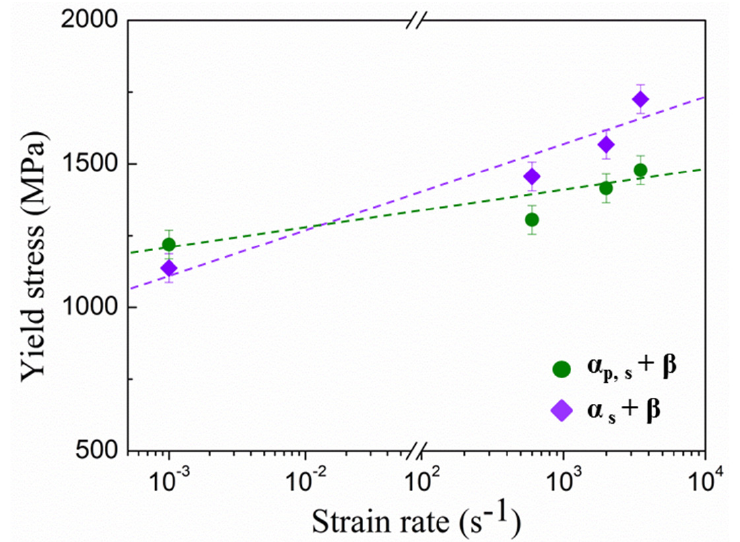
Figure 5. Yield strength of two kinds of α - β metastable β -Ti alloys at different strain rates. The quasi-static data (strain rate, 10 − 3 s − 1 ) were obtained from MTS testing system and dynamic data were obtained from SHPB (strain rate ~6 × 10 2 s − 1 , 2 × 10 3 s − 1 , and 4 × 10 3 s − 1 ).